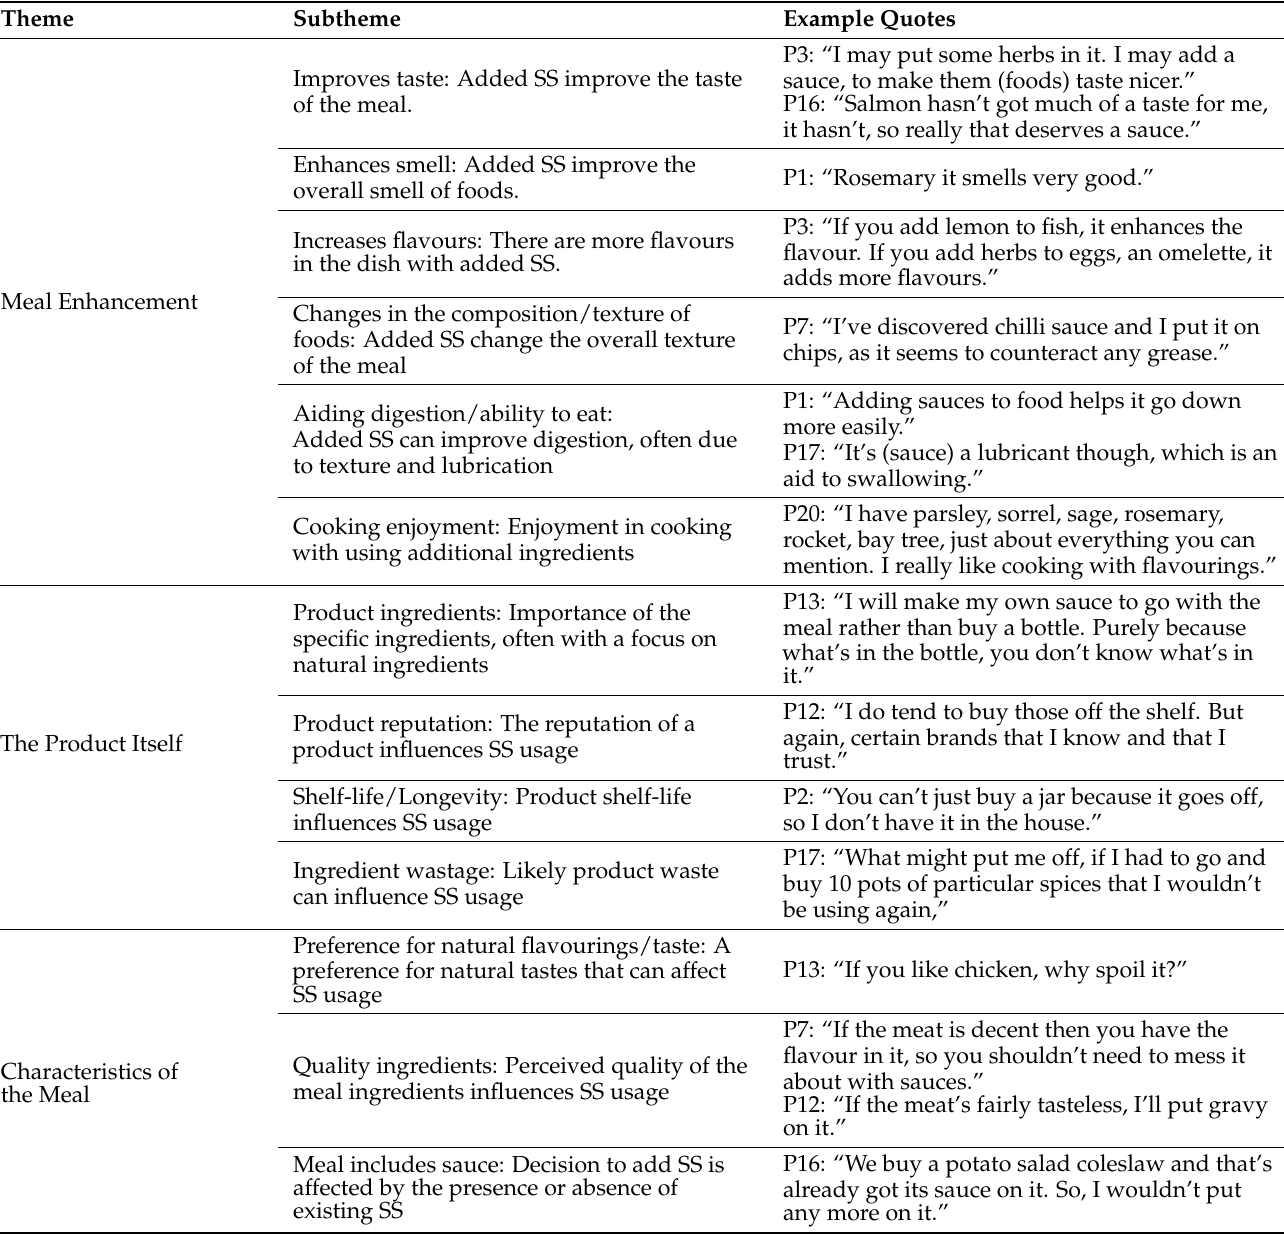
Table 3. Themes table from the qualitative analysis of the interviews, demonstrating themes, subthemes and example quotes. Further example quotes are provided in the Supplementary Materials.